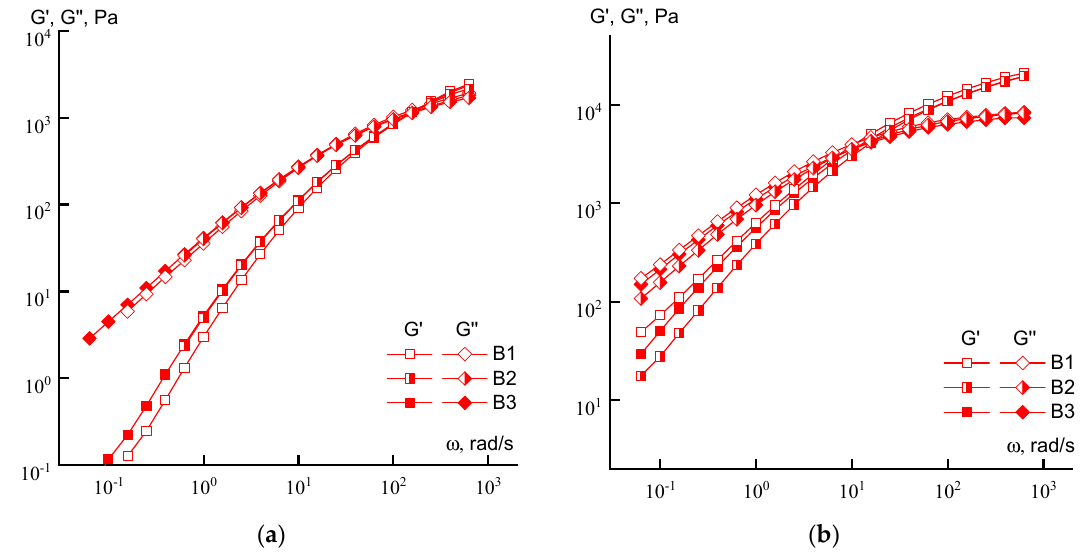
Figure 5. Dependences of the elastic and losses moduli on the frequency of copolymer solutions (series B) with a concentration of 10 ( a ) and 20% ( b ).